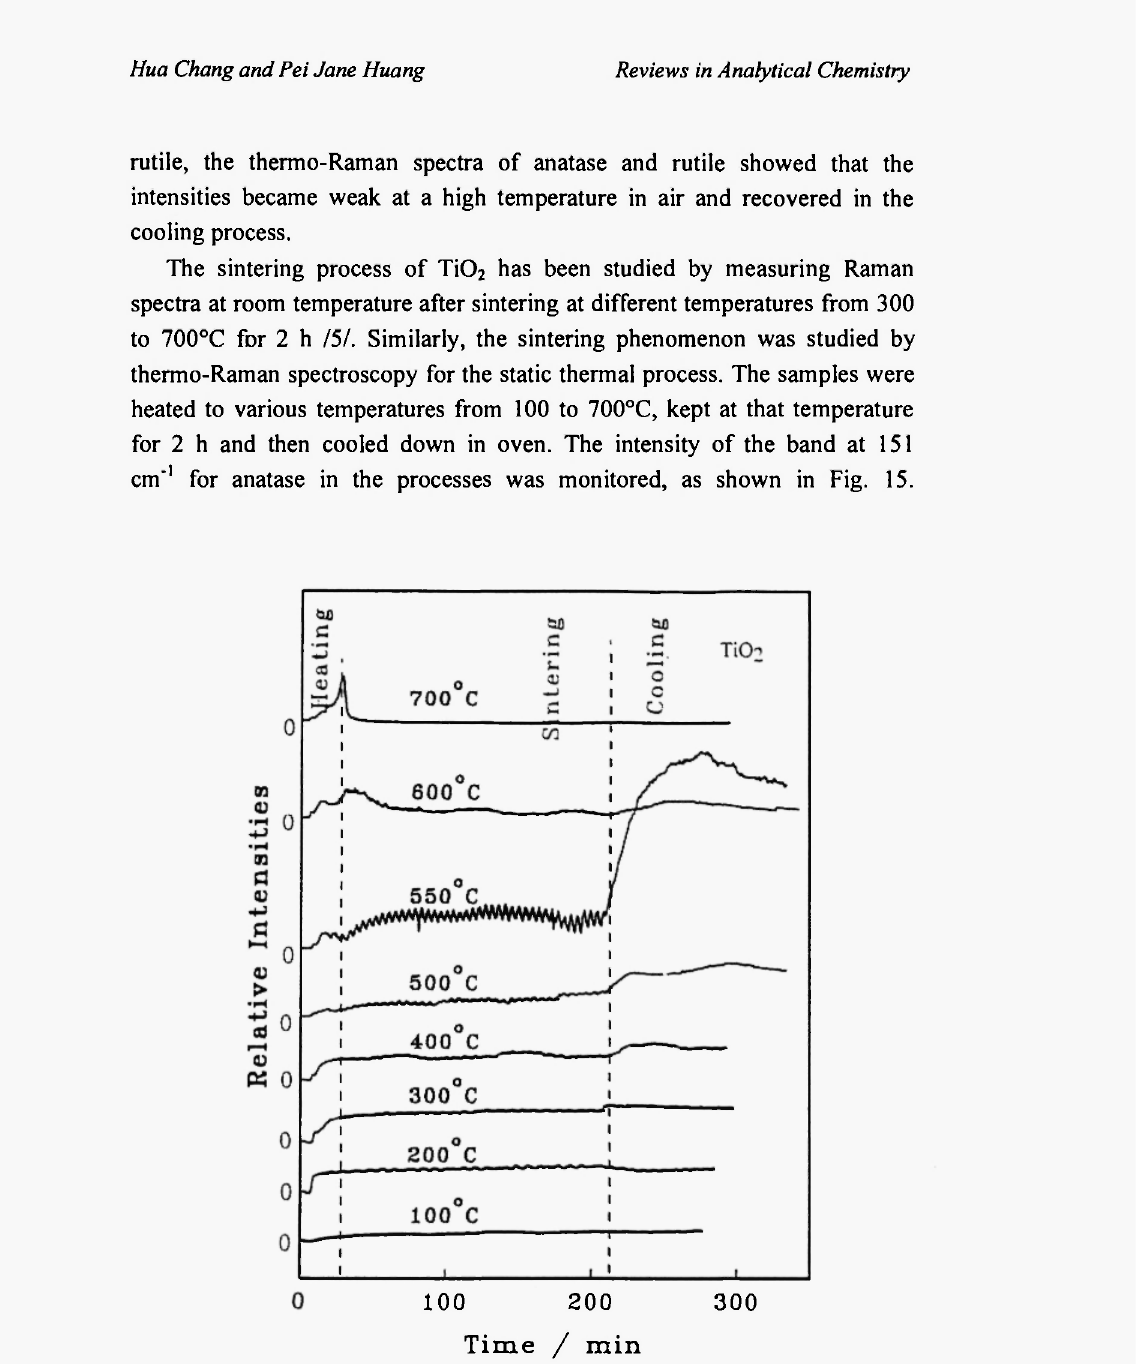
Fig. 15: The thermo-Raman intensity (TRI) thermograms for Ti0 2 gel in a static thermal sintering process at different temperatures from 100 to 700°C and oven-cooling (Ref.